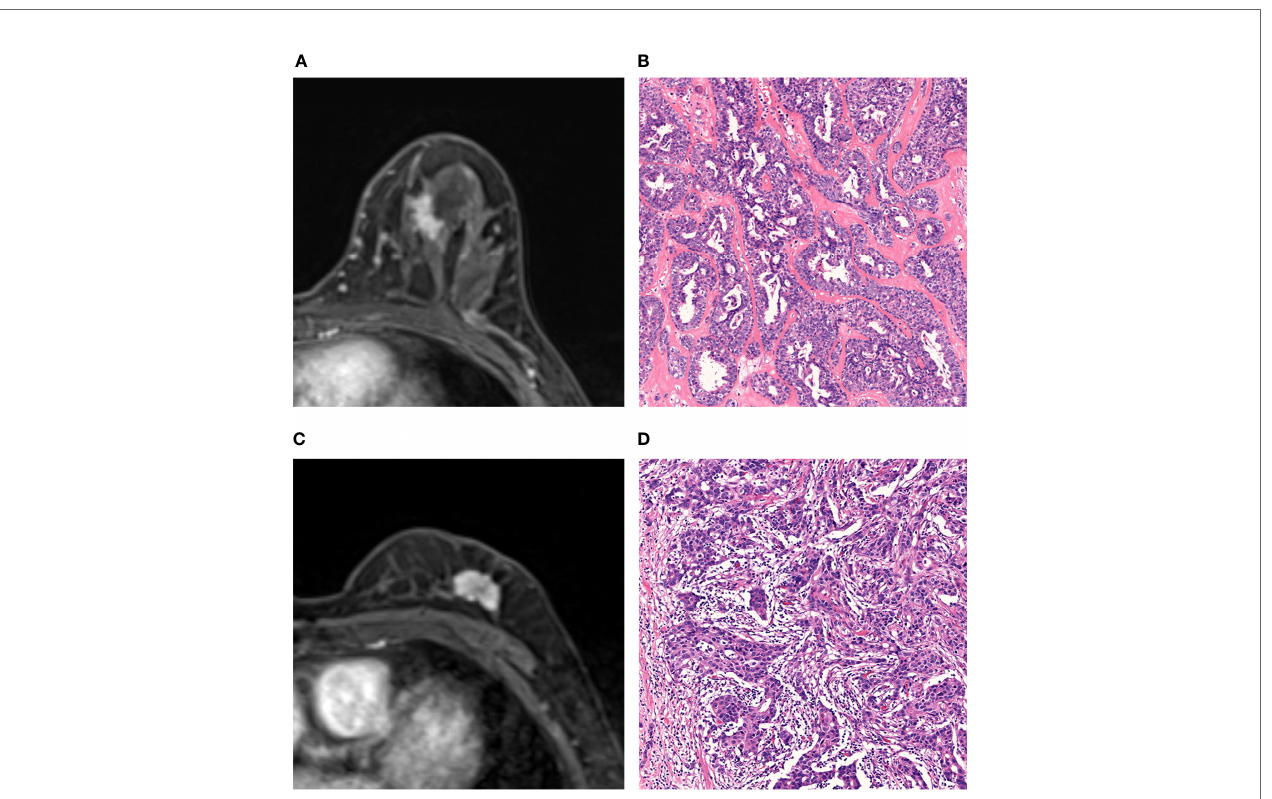
FIGURE 5 | MRI and histopathologic fi ndings of two cases of SA and IDC. (A, B) MRI and histopathologic fi ndings of a 47-year-old woman with SA. The DCE-MRI image showed an irregularly shaped mass with spiculated margin and heterogeneously enhancement (A) . The lesion was classi fi ed as malignant by BI-RADS analysis and benign by radiomic analysis. Histopathological examination proves SA (Hematoxylin-eosin staining; original magni fi cation×100) (B) . (C, D) MRI and histopathologic fi ndings of a 66-year-old woman with IDC. The DCE-MRI image showed an irregularly shaped mass with lobulated margin and heterogeneously enhancement (C) . The lesion was classi fi ed as malignant by both BI-RADS analysis and radiomic analysis. The histopathologic result was IDC (Hematoxylin-eosin staining, original magni fi cation×100) (D)